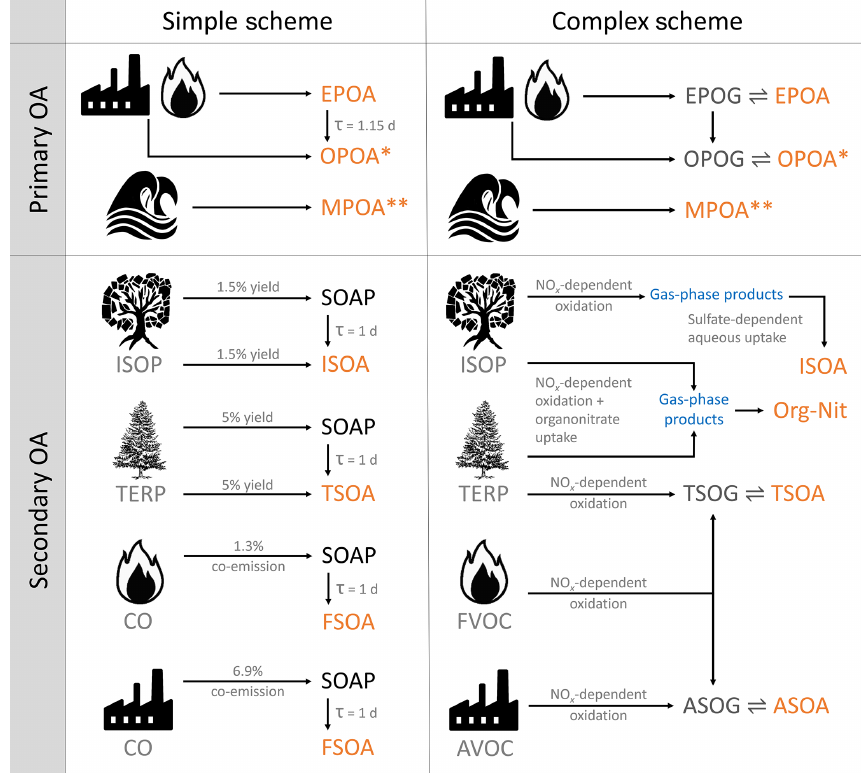
Figure 1. A graphical overview of the two organic aerosol model schemes in GEOS-Chem. TERP denotes monoterpenes and sesquiter- penes. Pyrogenic VOCs (FVOCs) denote the various volatile and semi-volatile organic compounds emitted from fires, while anthropogenic VOCs (AVOCs) are comprised of benzene, toluene, xylene and various intermediate-volatility organic compounds that are modeled us- ing naphthalene as a proxy. OPOA ∗ is sometimes classified as secondary organic aerosol from SVOCs. MPOA ∗∗ denotes lumped marine POA consisting of both fresh (M-EPOA) and oxidized (M-OPOA) components. Species in orange contribute to OA; images modified from https://openclipart.org/ (last access: 11 January 2018) and https://publicdomainvectors.org/ (last access: 5 December 2019). See Sect. 2.1 in the text for